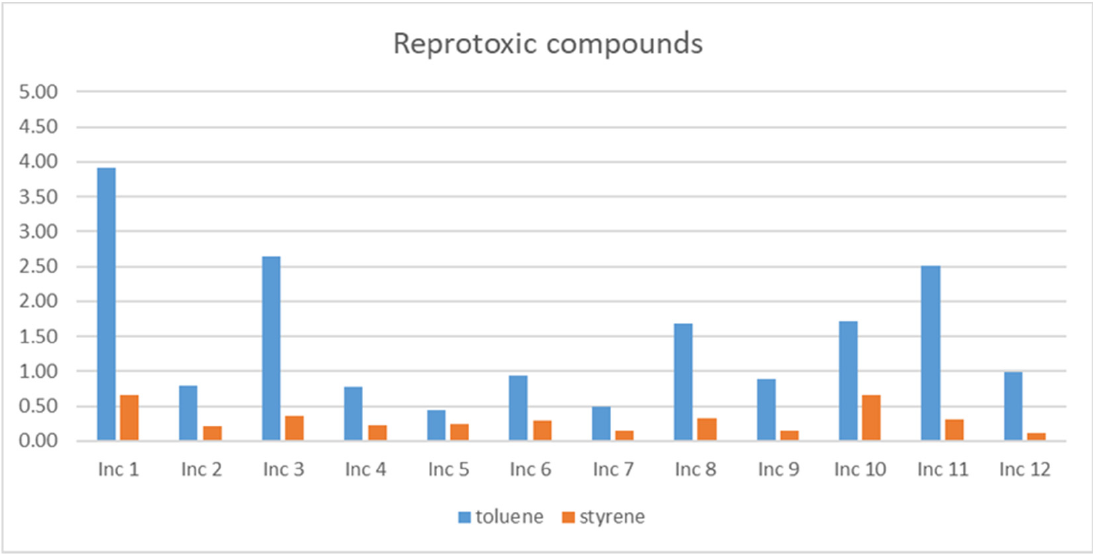
Figure 3. TWA levels ( μ g/m 3 ) of the reprotoxic compounds in the twelve products